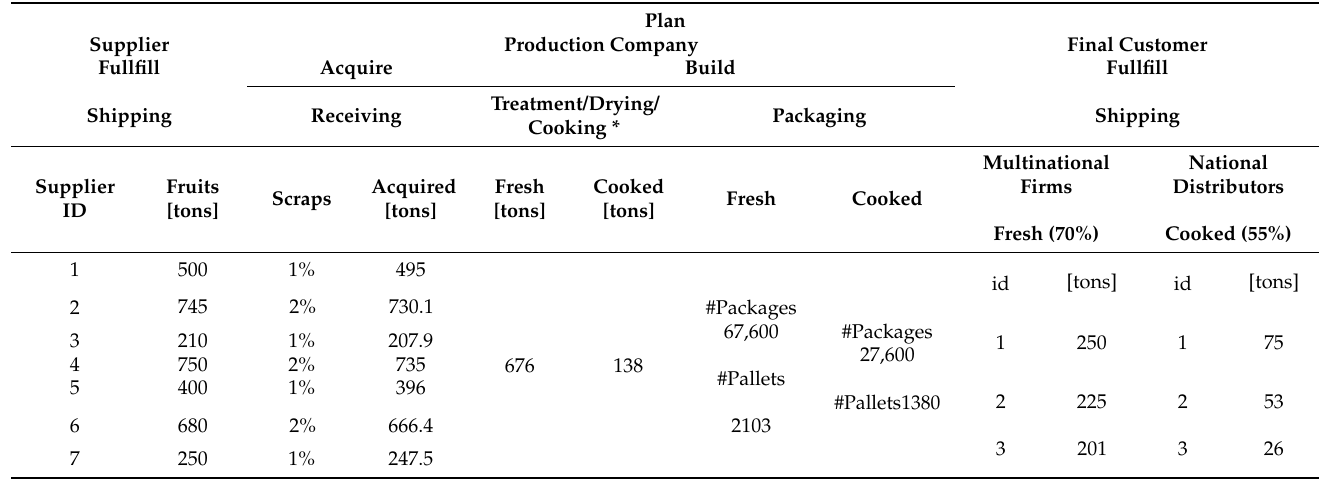
Table 4. VCOR configuration and quantities processed.